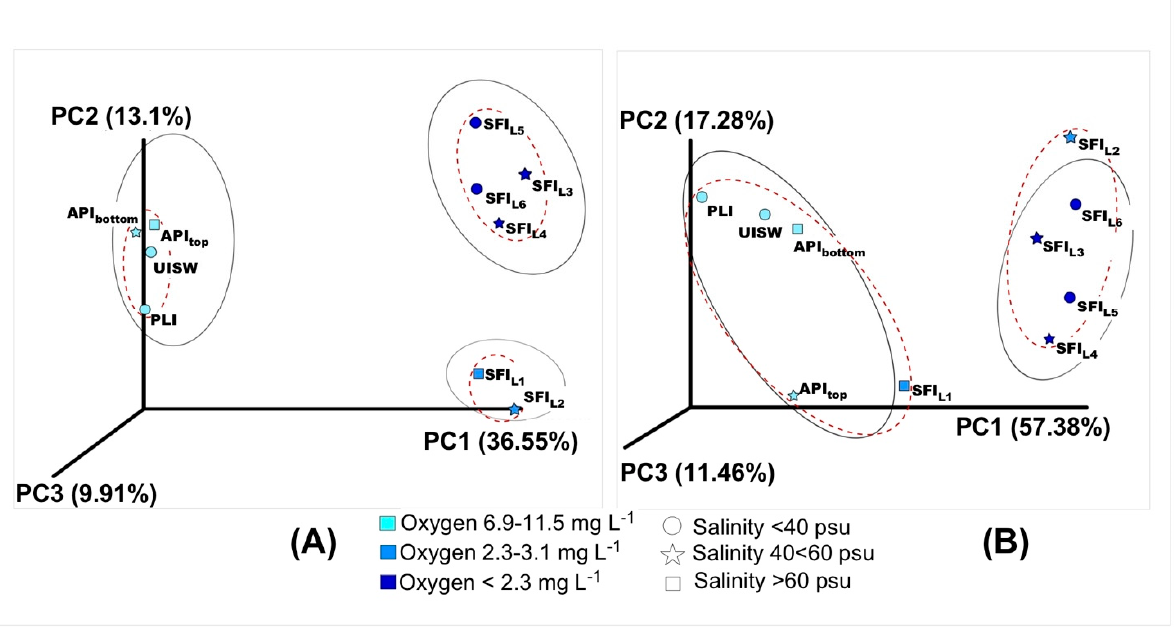
Figure 2. Principal component analysis (PCoA) of Antarctic sea-ice-associated microbial communities: ( A ) unweighted UniFrac, ( B ) weighted UniFrac. Abbreviations used: API—annual pack ice; PLI—platelet-ice interstitial water; UISW—under-ice seawater; SFI L1 − 6 —different layers of simulated fast ice.